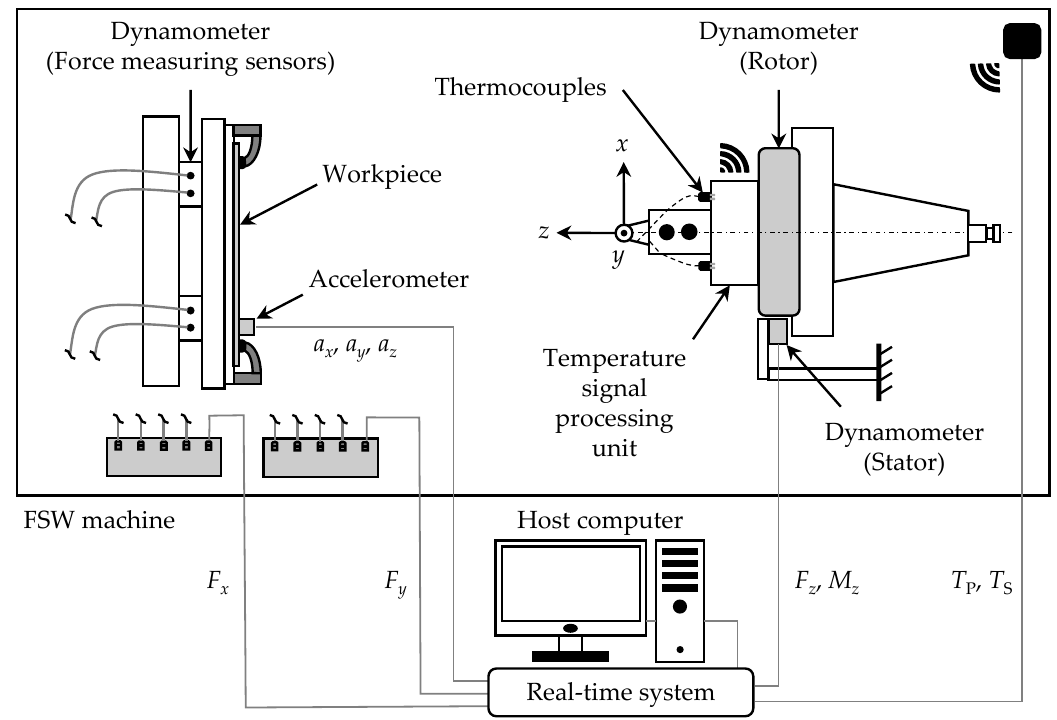
Figure 2. Experimental set-up with real-time system.